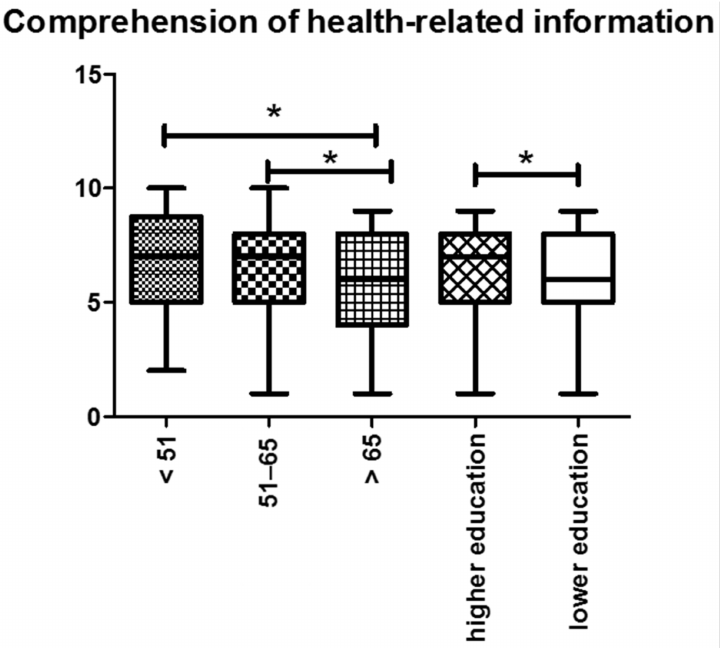
Figure 5. Comprehension of health-related information: We noticed a decreasing arithmetic mean value with increasing age of the participants. Additionally, the ability to comprehend health-related information was statistically significant in patients with higher levels of education. Abbreviations: * p <